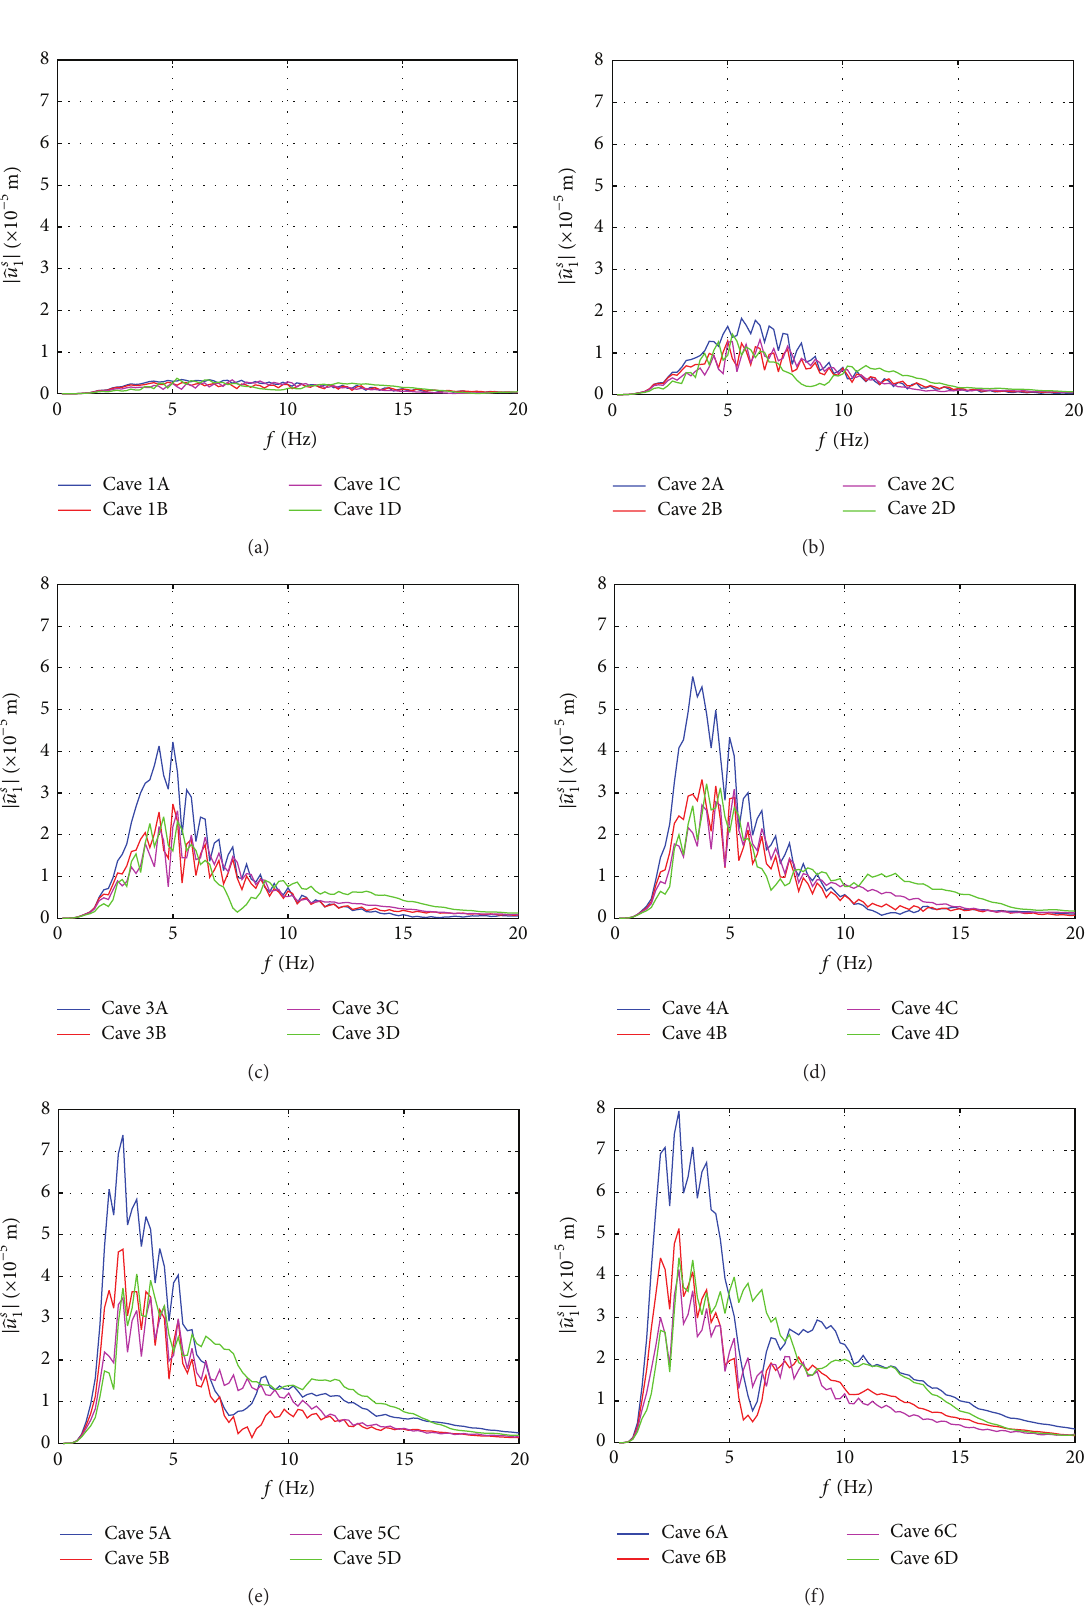
Figure 11: Frequency spectra |̂𝑢 𝑠 1 (𝑂, 2𝜋𝑓)| for different cave sizes and depth. Labels refer to Table